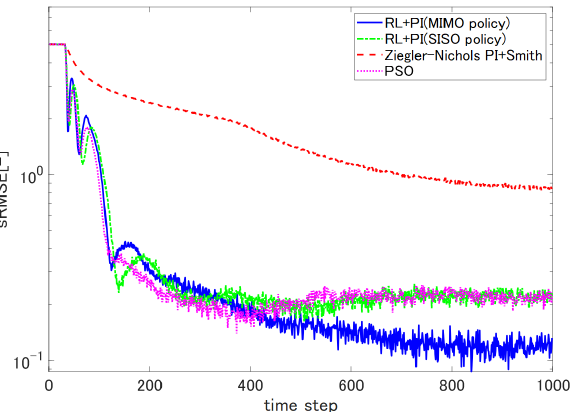
Figure 16. Transient changes in sRMSE metrics calculated with four different